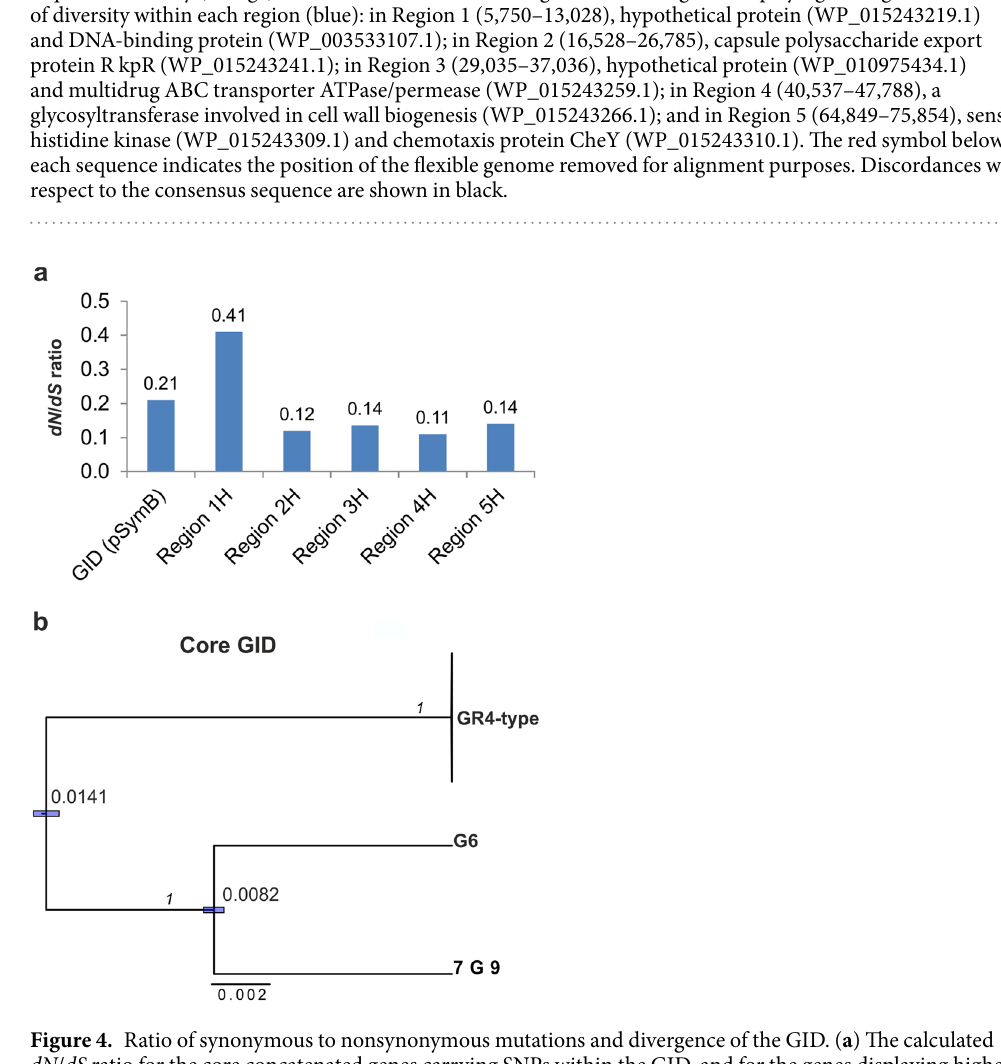
Figure 4. Ratio of synonymous to nonsynonymous mutations and divergence of the GID. ( a ) The calculated dN / dS ratio for the core concatenated genes carrying SNPs within the GID, and for the genes displaying higher (H) levels of nucleotide sequence diversity within each of the five regions of greater diversity (Fig. 3). ( b ) The maximum clade credibility tree estimated with BEAST 2, based on the alignment of the core GID. Node bars indicate the 95% credibility intervals (95% HPD) for node ages, which are also shown as nucleotide substitution per site; the posterior probability is shown above the branches (in italics). The cluster containing the other 19 sequenced GR4-type isolates and the reference GR4 strain was collapsed for